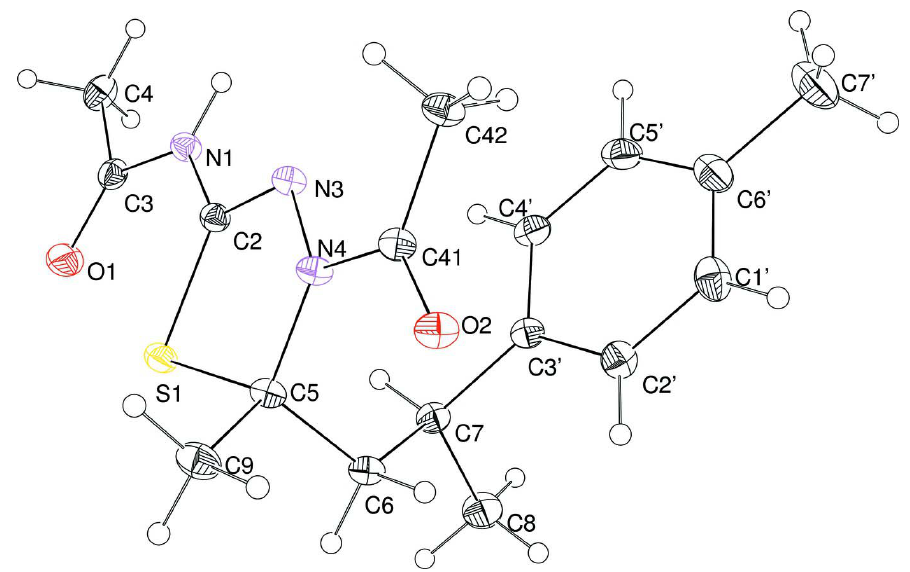
Figure 1 Molecular structure of the title compound with the atom-labelling scheme. Displacement ellipsoids are drawn at the 30% probability level. H atoms are represented as small spheres of arbitrary